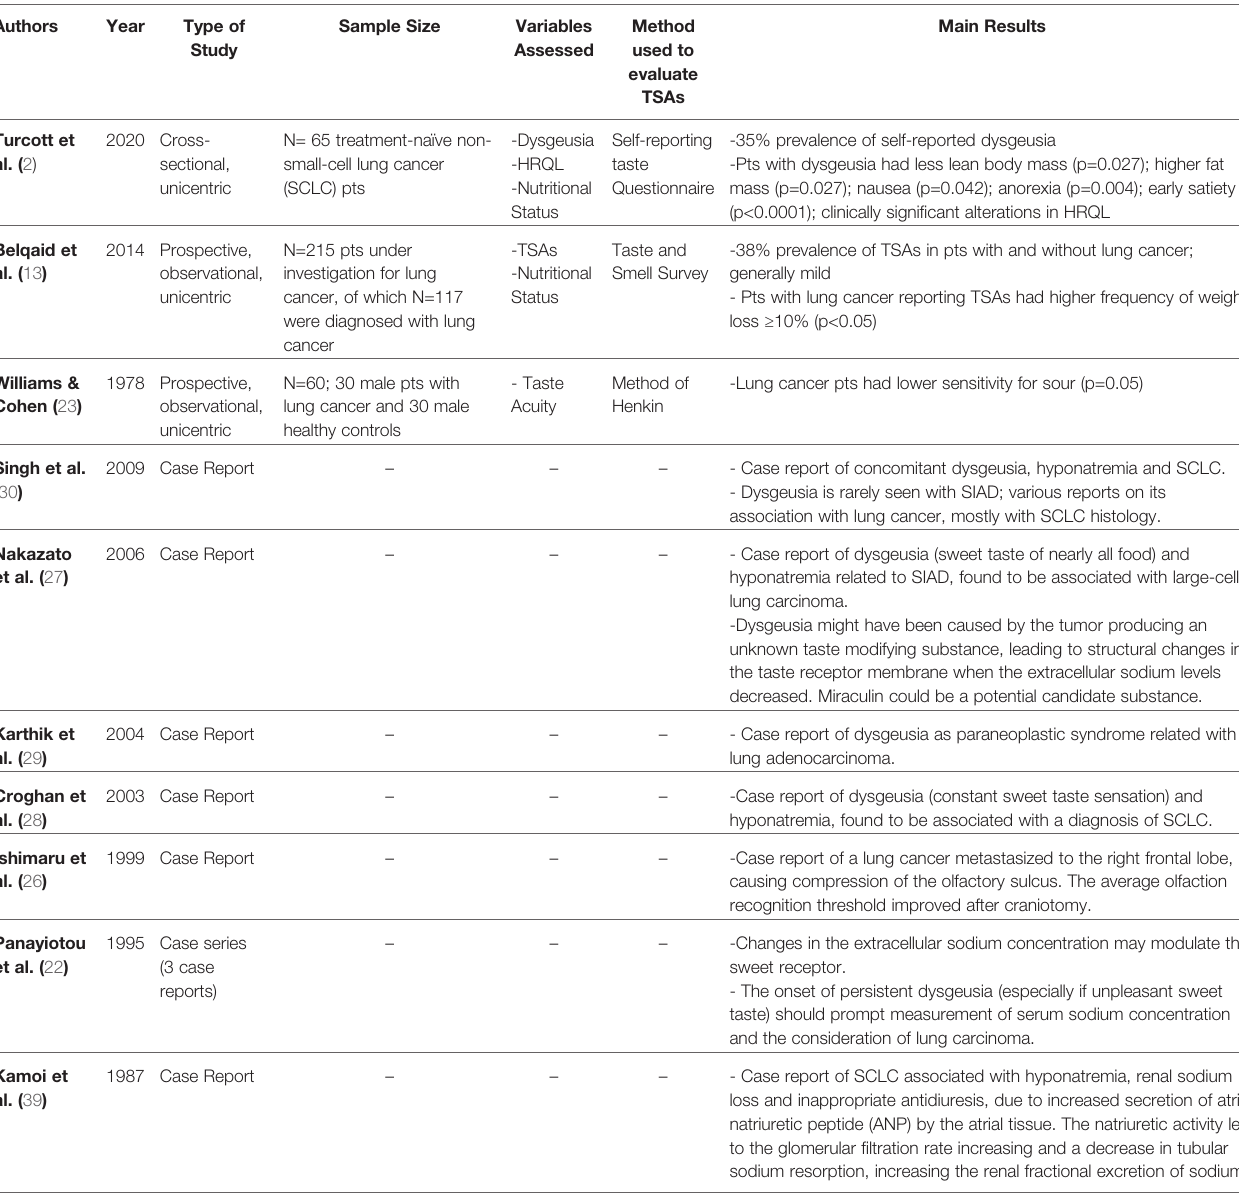
TABLE 2 | Summary of evidence concerning treatment-naïve lung cancer patients included in the